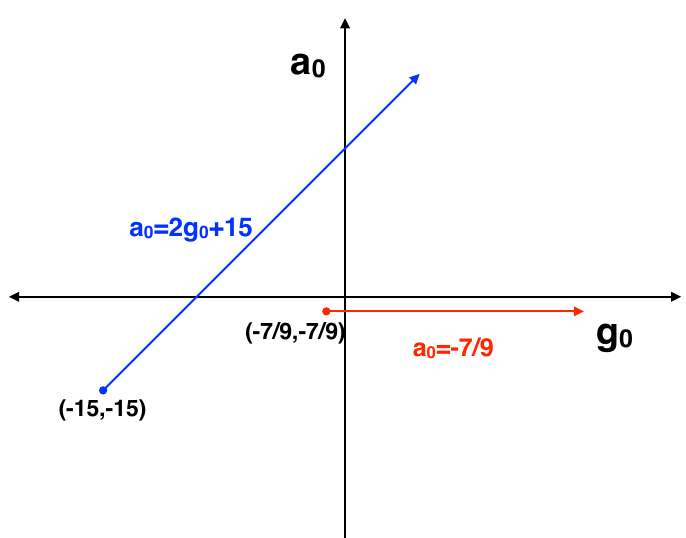
Figure 12. A sketch of the RG (cid:13)ows originating in the SUSY theory at (cid:21) = 1 = 4 and with m F > 0. On a generic point along the blue ray (5.17) we (cid:13)ow to the RF theory; at the beginning of this ray, the point ( 15 ; 15), we (cid:13)ow to the CF theory. On a generic point on the horizontal red ray (cid:0) (cid:0)